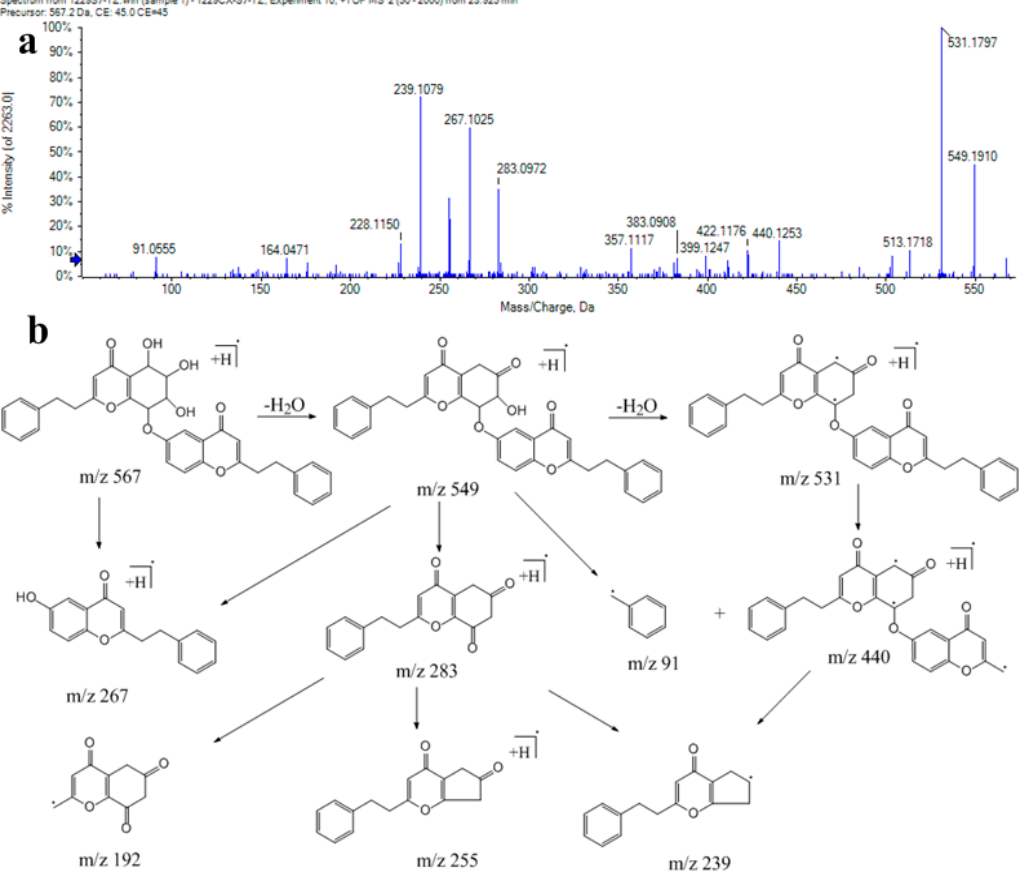
Figure 4. ( a ) MS/MS spectrum of compound 117; ( b ) proposed fragmentation pathway of ( a ) MS/MS spectrum of compound 117; ( b ) proposed fragmentation pathway of compound 117. compound